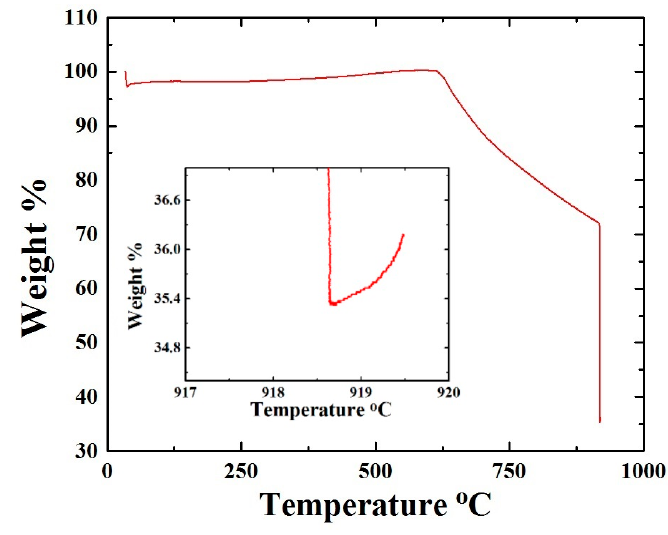
Figure 4. TGA analysis of the as grown buckypaper.